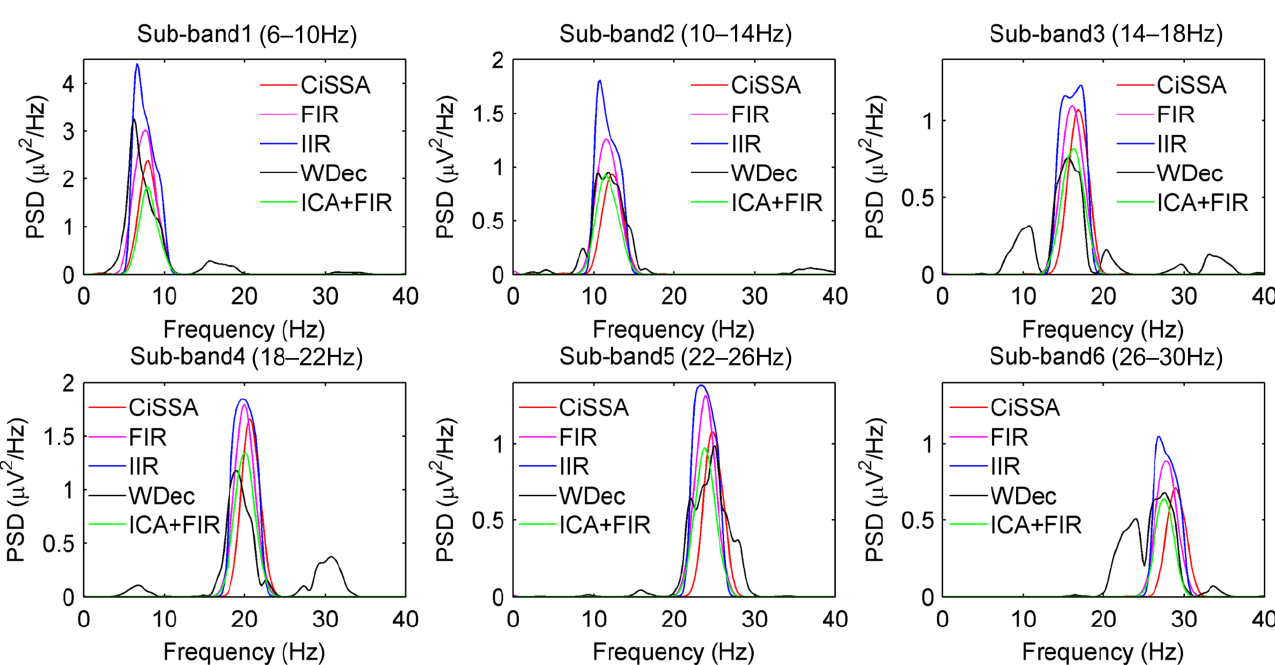
Figure 5. The power spectrum density (PSD) of the sub-bands extracted by CiSSA, FIR, IIR, WDec, and ICA + FIR for subject av at electrode C3. The PSDs of sun-bands extracted by FIR and IIR are higher than those by CiSSA and ICA + FIR. The PSDs of sun-bands extracted by WDec contain components falling outside the frequency width (e.g., 6–10 Hz for